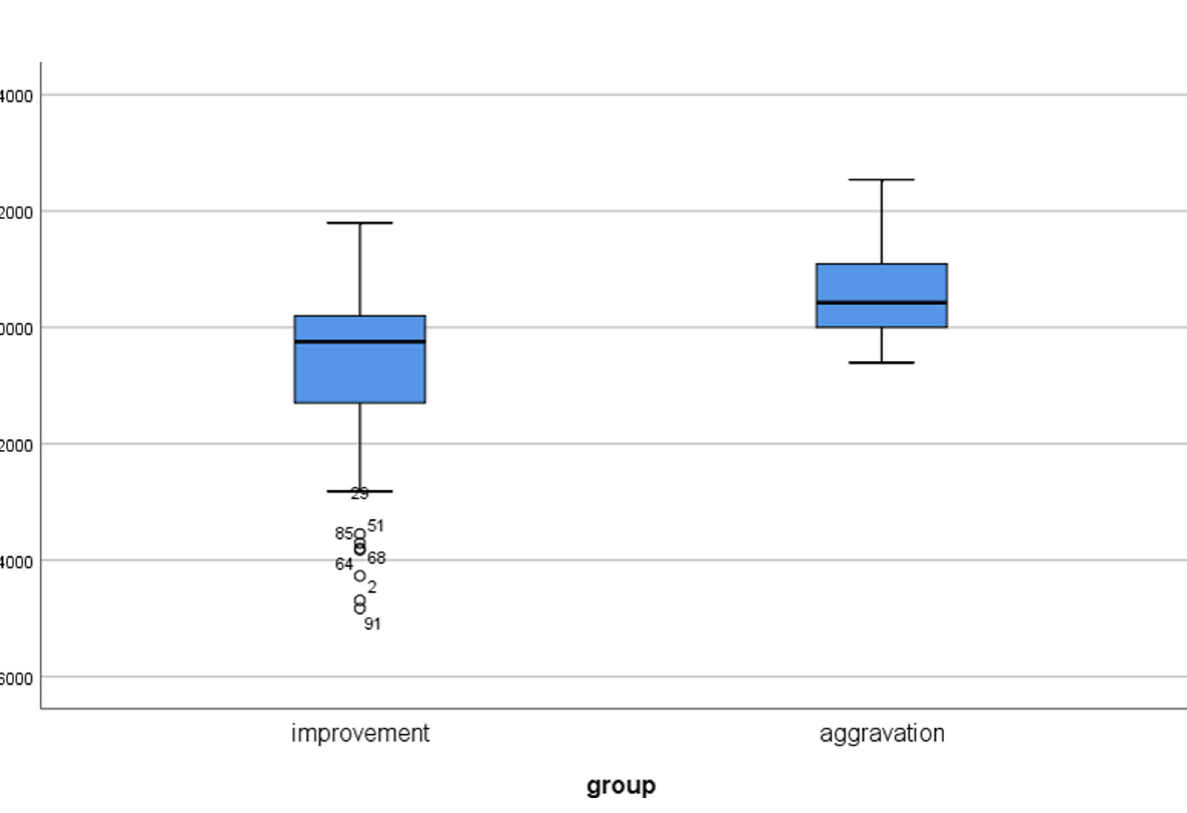
PLOS ONE | https://doi.org/10.1371/journal.pone.0249399 April 15,